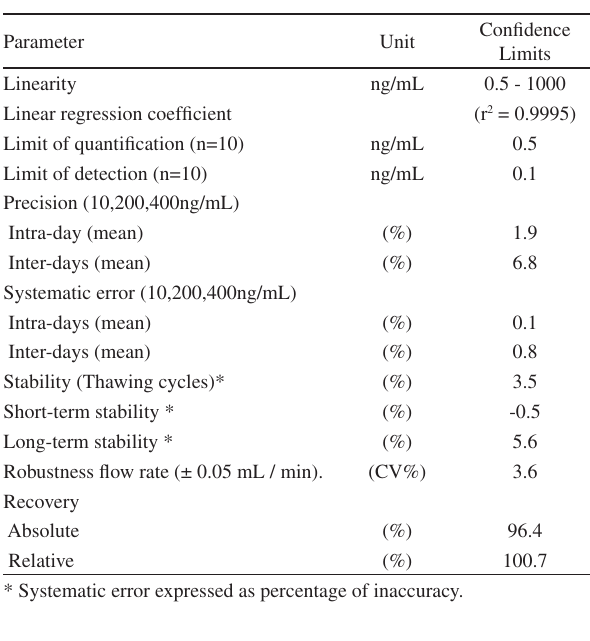
Table 2 - Confidence limits of analytical method to determine plasma morphine concentration